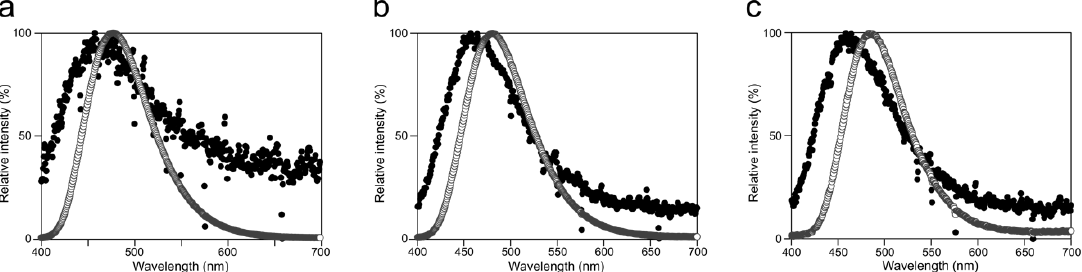
Figure A1. Luminescence emission spectra of Cypridina luciferin in the presence of hAGP or a recombinant CLase from C. noctiluca : spectra ( a ) in 50 mM Tris-HCl (pH 7.5), ( b ) in 50 mM Tris-HCl (pH 8.5), and ( c ) in 50 mM Gly-NaOH (pH 10.5). Closed circles, with hAGP; open circles, with CLase.